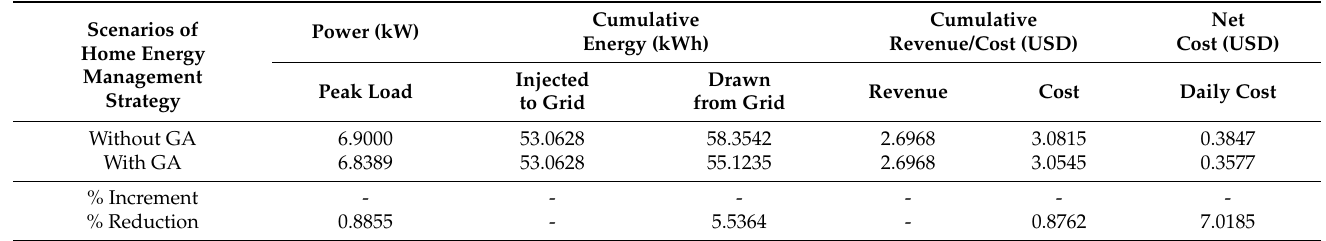
Figure 16. Comparison of energy costs of the consumer using strategies with and without GA. The comparison of the results obtained from the home energy management strategies with and without GA combination is presented in Table 3. The strategy with the GA can decrease the cumulative drawn energy from the grid from 58.3542 kWh to 55.1235 kWh. Therefore, the cumulative cost for the consumer is decreased from 3.0815 USD to 3.0545 USD. In consequence, the daily electrical energy cost for the consumer is decreased from 0.3847 USD to 0.3577 USD. Moreover, the strategy with the GA can equalize the household load in the third period and decreases the peak household load from 6.9000 kW to 6.8389 kW; consequently, the utility grid does not have to supply high power to the household for a long time. Table 3. Comparison of the results between using strategies with and without the GA.